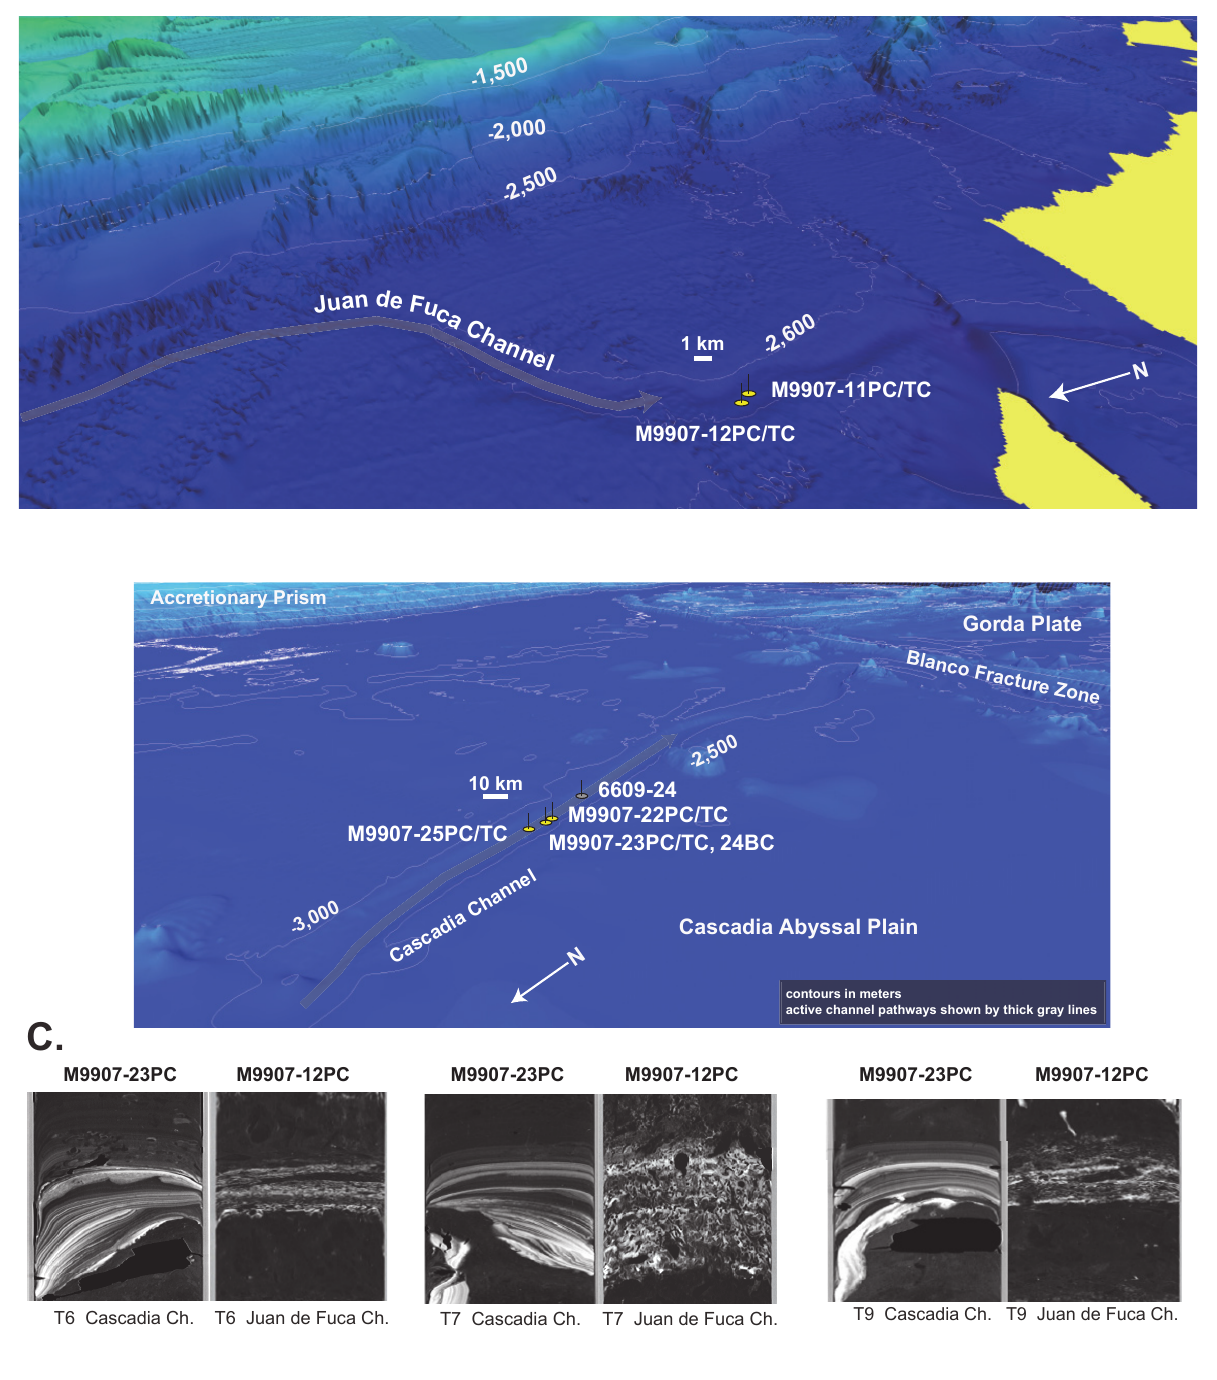
Fig. 9. (B) Low angle oblique view of core sites. Because the map is oblique, the scale bar is only relevant nearest the core locations. (C) CT scan data from cores 23PC (Cascadia channel) and 12PC (Juan de Fuca channel) are compared for three well-correlated turbidites T-6, T-7, and T-9. The JDF imagery is “flattened” to the upper and lower sand contacts of the corresponding Cascadia channel units. These examples show the relatively unchanged internal structure of these typical events after passing the confluence at Willapa channel and ∼ 350km of transport. JDF channel imagery is degraded significantly by numerous small gas evolution voids, but the structural similarity is still evident. The primary structure of two pulses and three pulses for T9 and T6, respectively, is matched by density and magnetic peaks. T7 shows more pulsing ( ∼ 7) than is resolvable with the geophysical data, but it is apparent in both